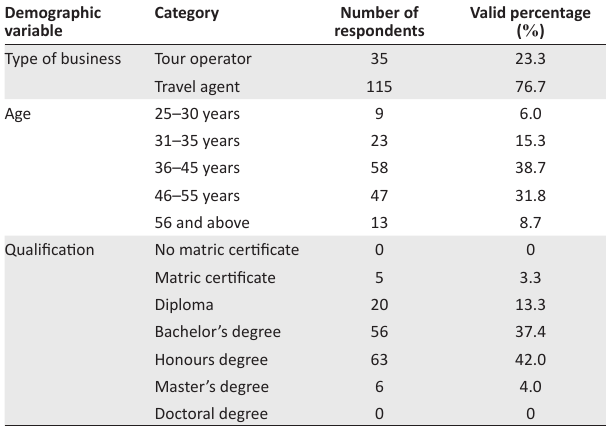
TABLE 1: Demographic